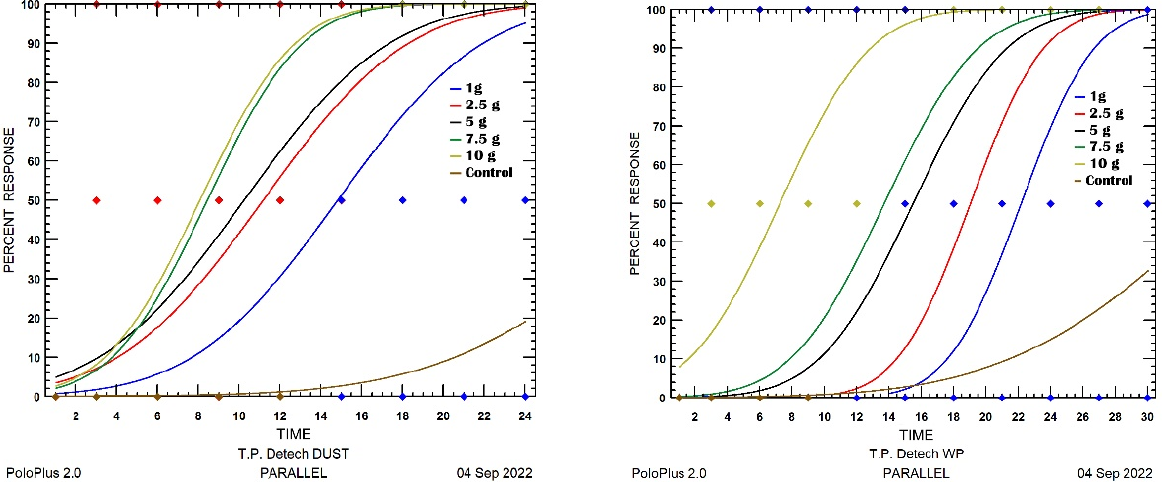
Figure 2. Dose–response (%) of Tyrophagus putrescentiae exposed to five different concentrations of Detech ® WP 95 and Detech ® Dust for certain observation times.